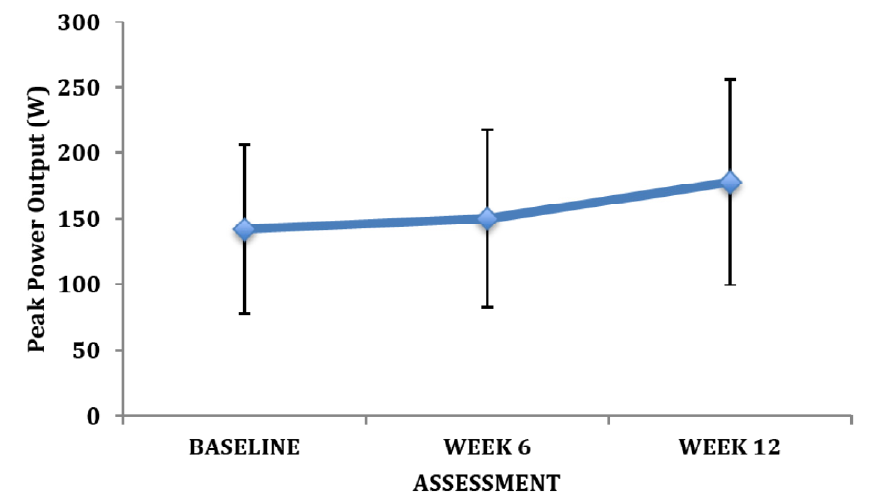
Figure 3. Changes in peak power with exercise intervention (mean ± SD).